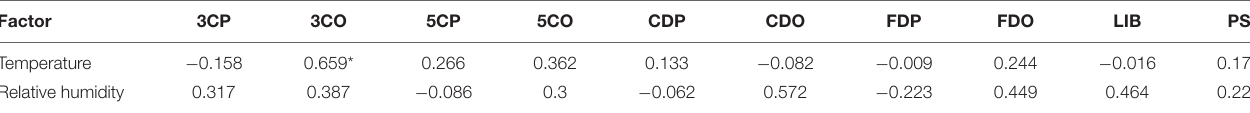
FIGURE 11 | Shannon index variations across seasons at different sampling sites. (A) Canteen 3, (B) Canteen 5, (C) Chinese student Dorm, (D) Foreign student Dorm, (E) Library and Peiyang Square. TABLE 5 | Pearson correlation analysis between Shannon index and environmental factors from different sampling